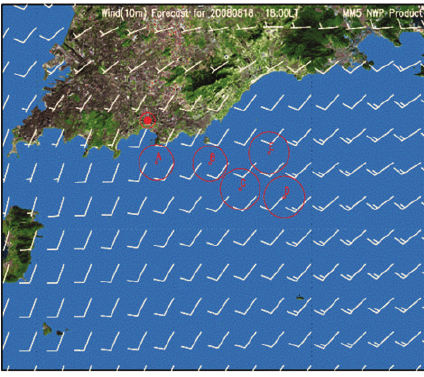
Figure 7: Distribution of wind vector at the height of 10m at 15:00 LST of 18 August, 2008.